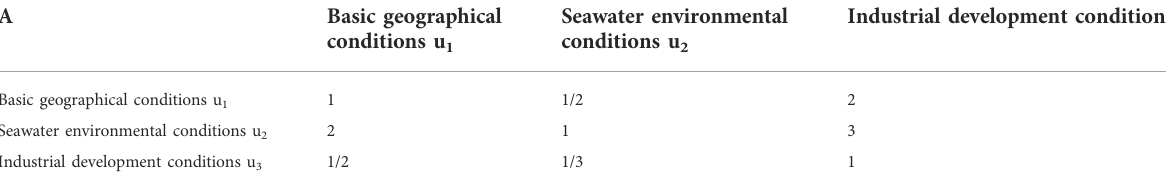
TABLE 5 Quantitative judgment of the relative importance of the element layer.